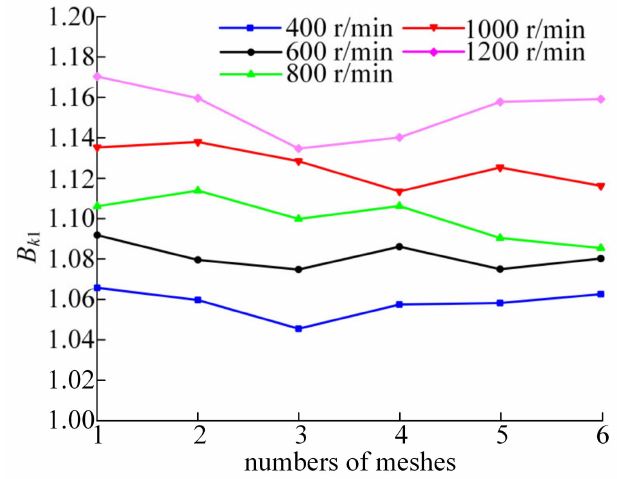
Figure 18. Load proportion coefficient curves under different speeds.